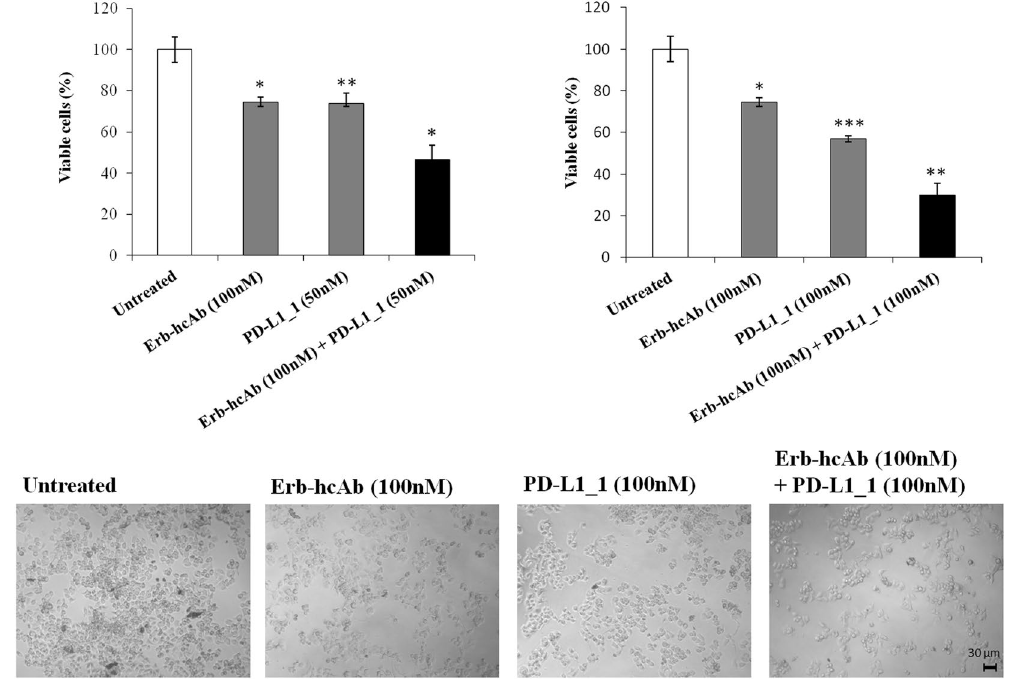
Figure 7. Combined treatments of Erb-hcAb and PD-L1_1 on SK-BR-3 tumor cells. SK-BR-3 cells were treated for 72 hours with Erb-hcAb or PD-L1_1 mAb, alone or in combination, at the indicated concentrations. SK- BR-3 cell survival is expressed as percent of viable treated cells with respect to untreated cells. Images of SK- BR-3 cells untreated or treated with each indicated compound or with the indicated combination. Error bars depicted means ± SD. P values for the indicated mAbs relative to untreated cells, are: *** P ≤ 0.001; ** P < 0.01; * P < 0.05. Scale bar = 30 μ